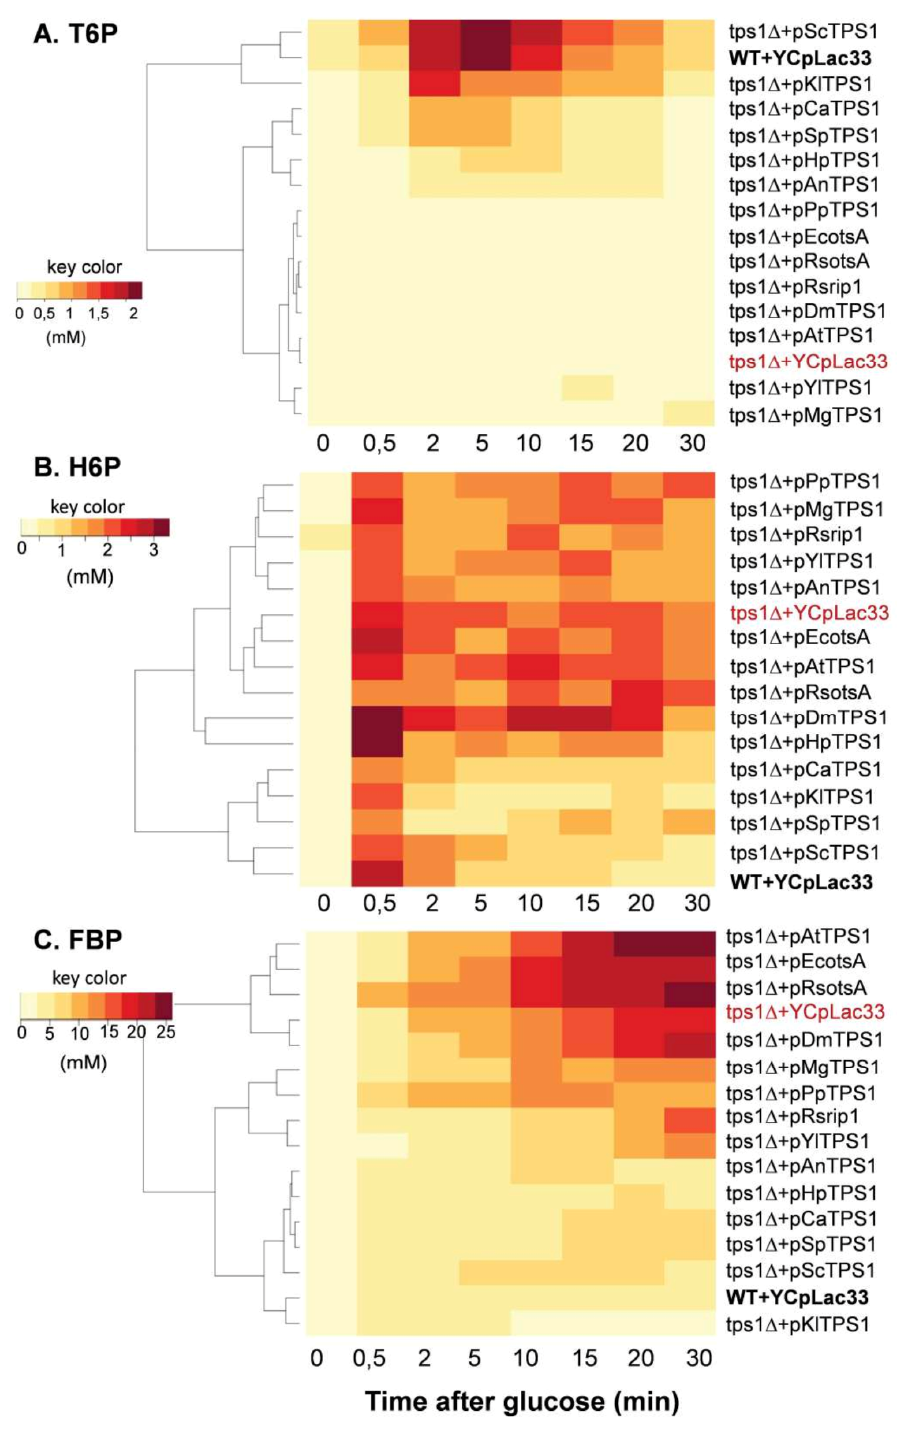
FIGURE 5: Heat map repre- sentation of the change in T6P (A), H6P (B) and FBP (C) concentration in S. cerevisiae tps1 mutant expressing TPS1 from different organisms in response to a glucose pulse. The Sctps1 strain transformed with YCpL33 plasmid bearing TPS1 homologue was